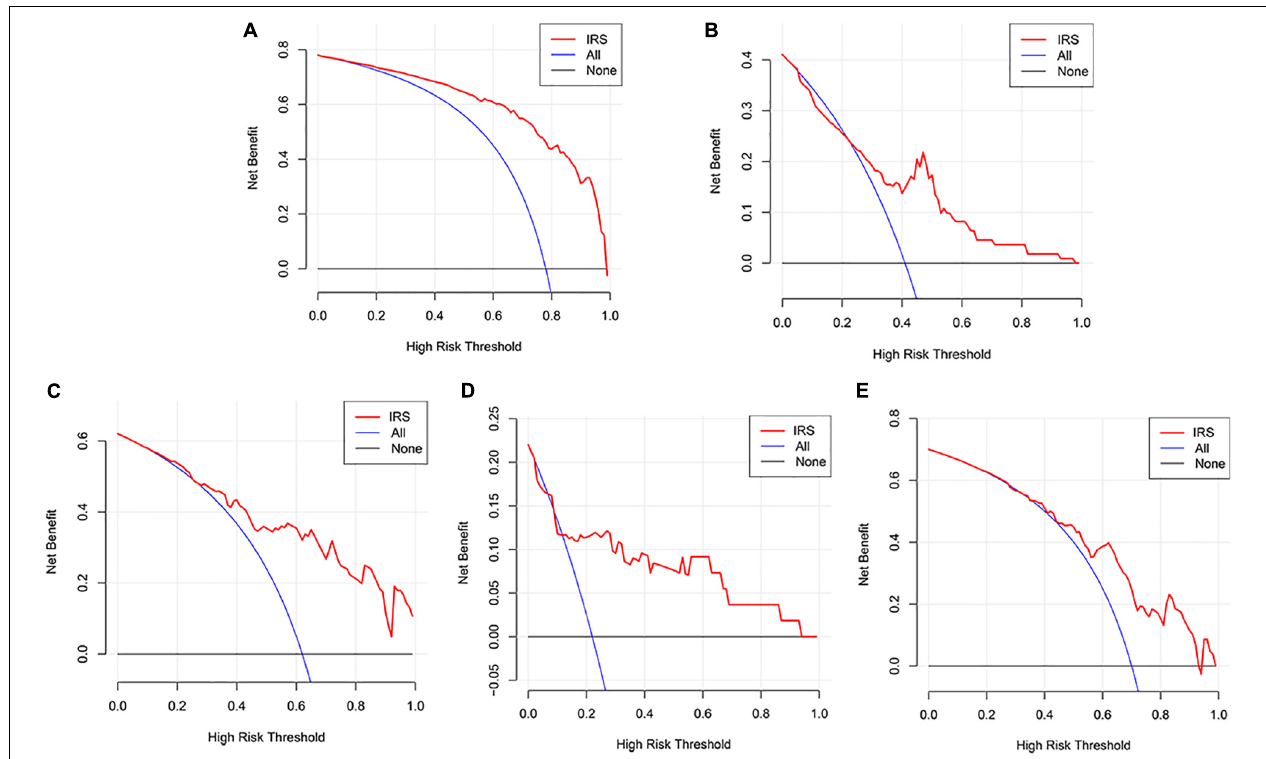
FIGURE 2 | Decision curve analyses of the IRS. (A) Decision curve analyses for the sequencing samples. (B) Decision curve analyses for the initial diagnosis patients. (C–E) Decision curve analyses for melanoma cohorts from GEO datasets ( C: GSE8401, D: GSE15605, E: GSE46517).